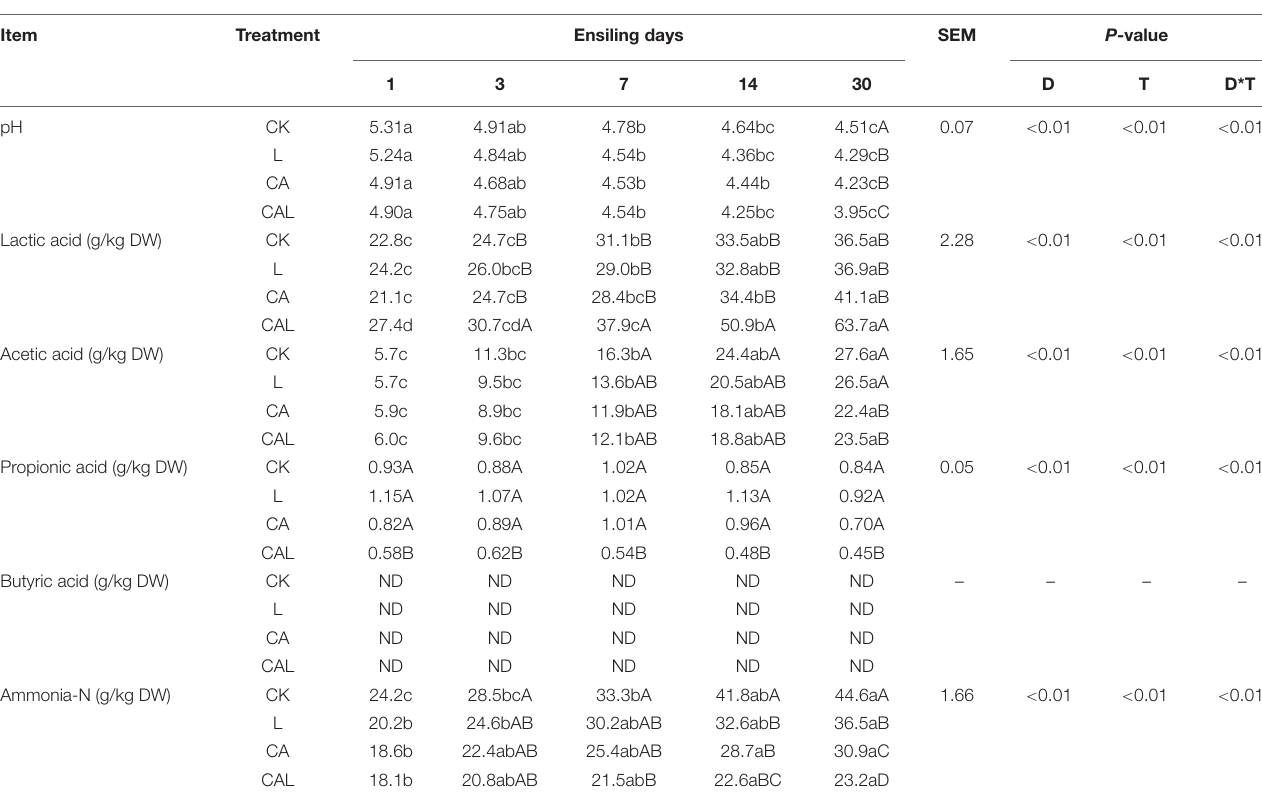
TABLE 3 | Fermentation quality of ensiled KG.